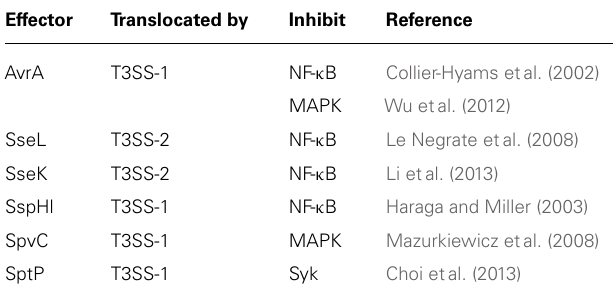
Table 1 | Salmonella effectors which inhibit immune signaling